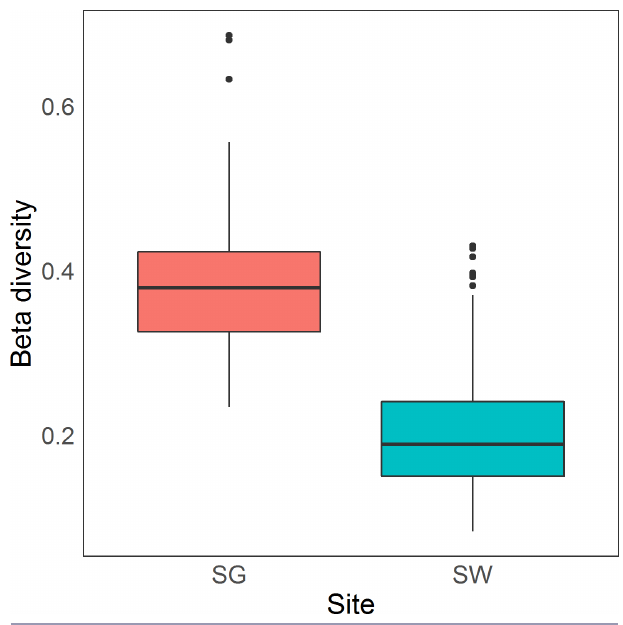
Fig. 2 . Box-plot of the measure of beta diversity for sacred groves (SG, red) and surrounding woodlands (SW, blue; ANOVA, p <